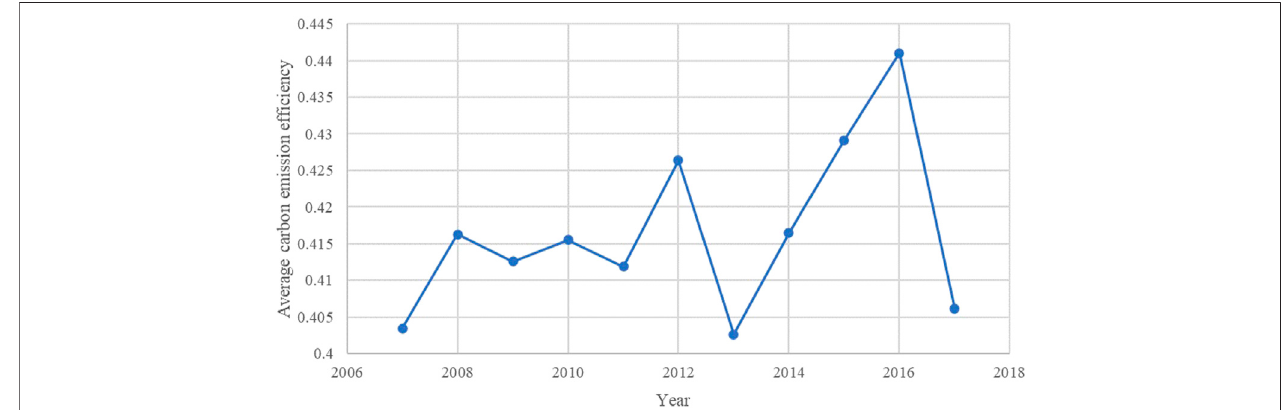
FIGURE 2 | Average level of carbon emission ef fi ciency of Chinese cities from 2007 to